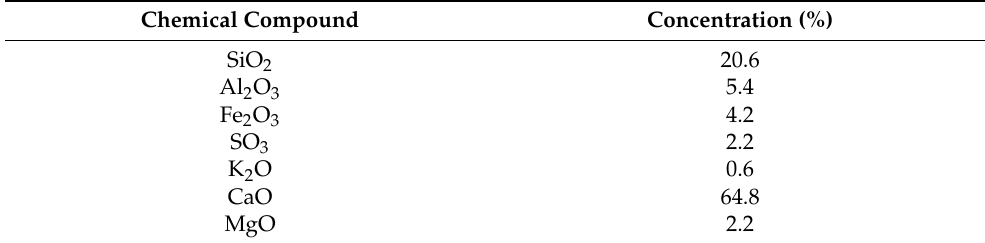
Table 1. Summary of the chemical composition of the OPC.